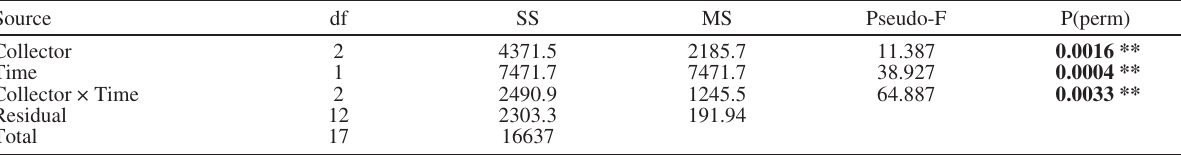
Table 3. – Results of the two-way permutational analysis of variance (PERMANOVA) performed to identify significant differences in the number of A. lixula settlers between the factors ‘Collector’ and ‘Time’ at the Canary Islands site (Abades). Significant results are shown in bold (** p<0.01).